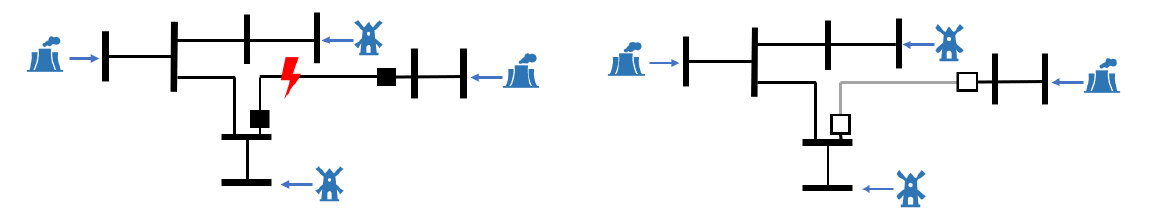
Figure 7. Power system with distributed and utility sources—all sources